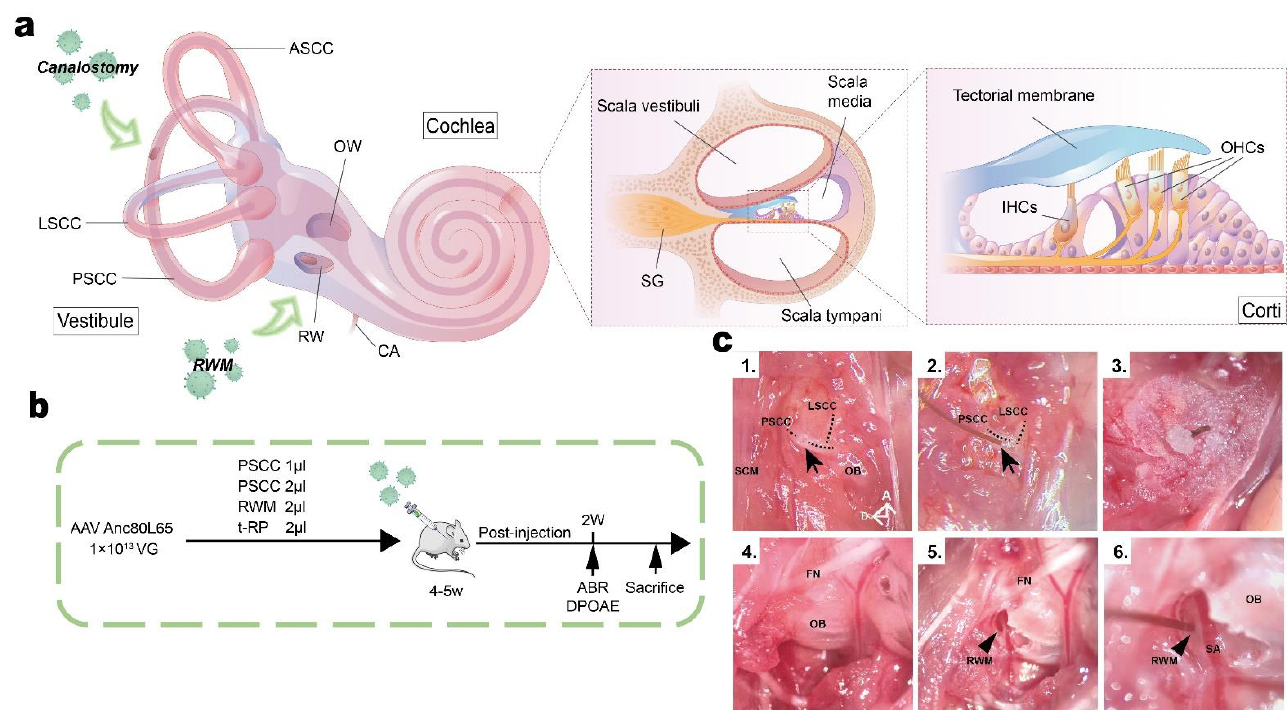
Figure 1. Overview of inner ear structures, the experimental design, and images showing the PSCC and RWM approaches. ( a ) Schematic diagram showing the anatomy of the inner ear and different surgical approaches. Green arrows show where the AAVs were injected. ( b ) The experimental timeline for delivery of AAV vectors with different surgical approaches. ( c ) Surgical pictures showing the PSCC ( c1 – c3 ) and RWM ( c4 – c6 ) approach. Black arrows indicate the hole in the PSCC before ( c1 ) and after ( c2 , c3 ) the inoculation. Black arrowheads indicate the RWM location ( c5 ) and the RWM inoculation ( c6 ). PSCC: posterior semicircular canal, LSCC: lateral semicircular canal, ASCC: anterior semicircular canal, OW: oval window, RW: round window, CA: cochlear aqueduct, SG: spiral ganglion, SCM: sternocleidomastoid muscle, OB: otic bulla, FN: facial nerve, RWM: round window membrane, SA: stapedial artery, D: dorsal, A: anterior.